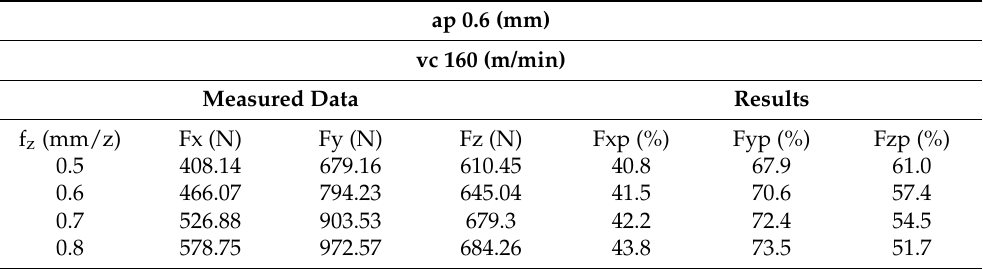
Table 9. Results for ap = 0.7(mm) and vc = 160 (m/min).